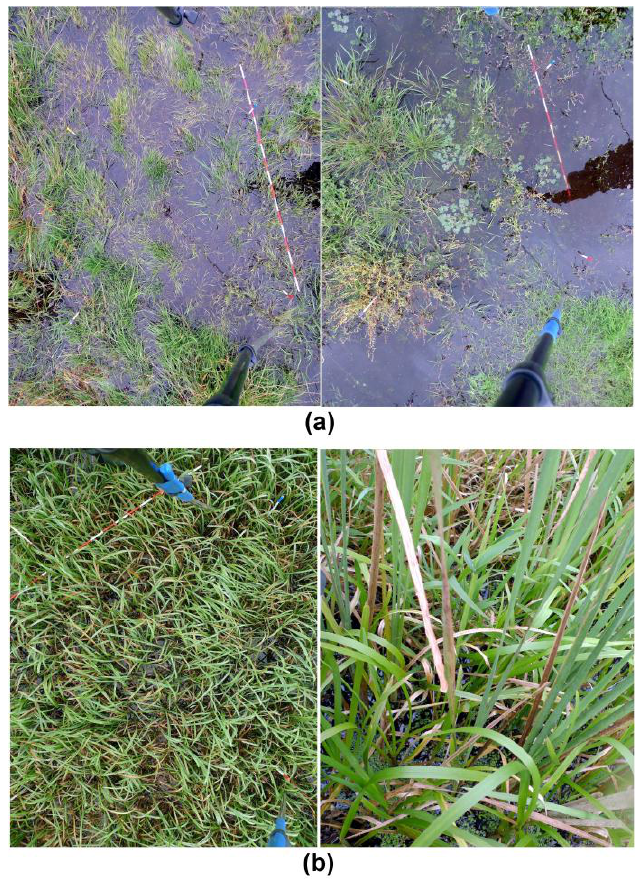
Figure 5. Examples of land cover representing flooded classes: ( a ) mixed water and vegetation class (W-V); ( b ) water under vegetation canopy class